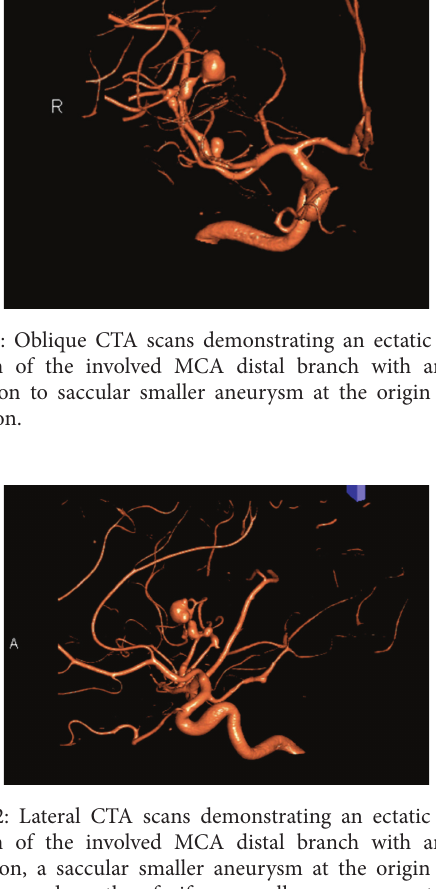
Figure 4: Lateral view of cerebral angiographic (DSA) image demonstrating an 8mm right M3-MCA fusiform aneurysm with disease ectatic parent